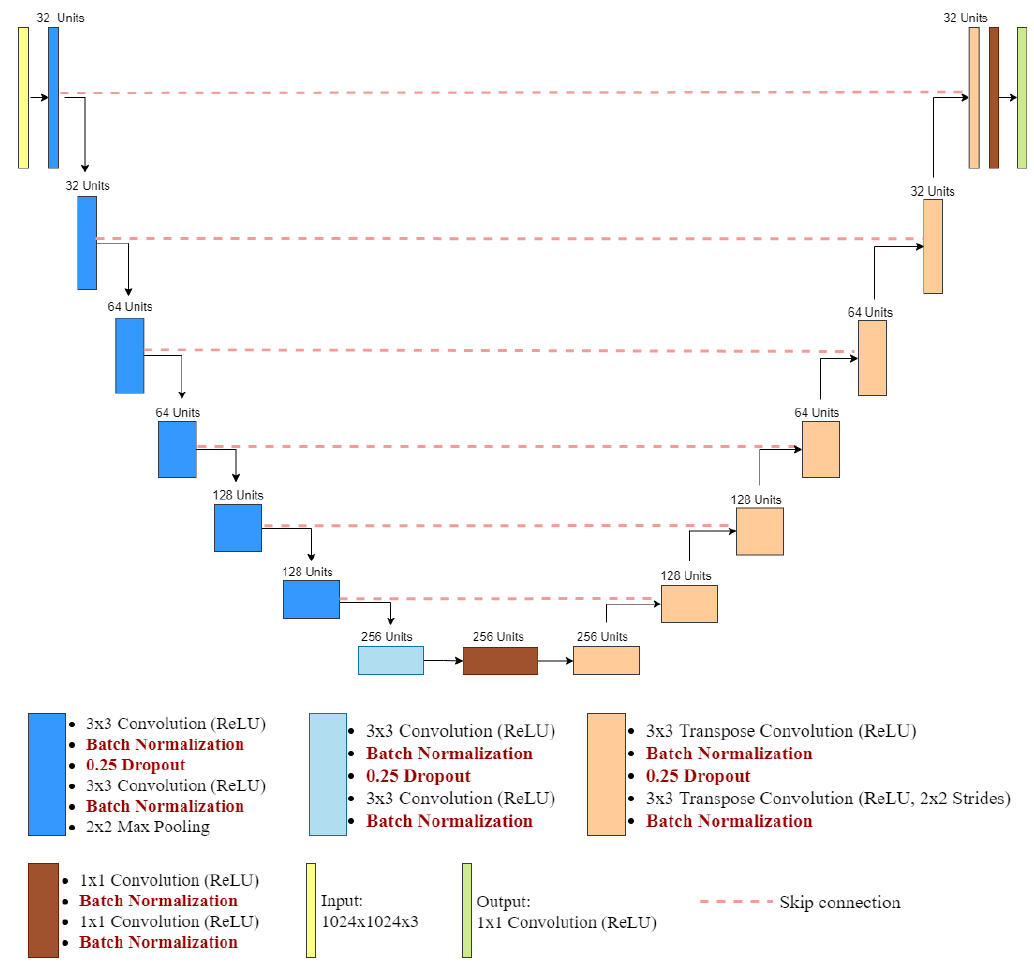
Figure 4. Proposed U-Net model (dropouts and batch normalizations added units are shown in dark red).